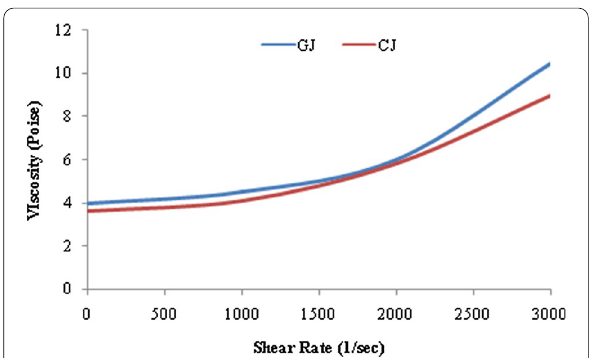
Fig. 2 Viscosity of guava leaf extract jelly and control jelly as a function of shear